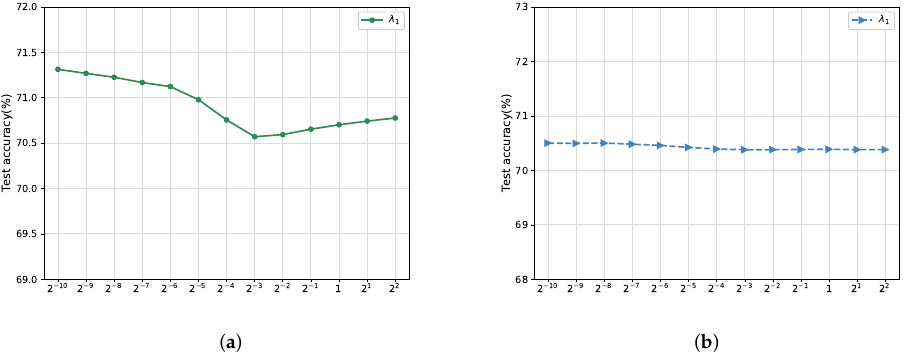
Figure 8. Influences of parameters λ 1 . ( a ) shows experimental results on NWPU-RESISC45, and ( b ) shows experimental results on RSD46-WHU.